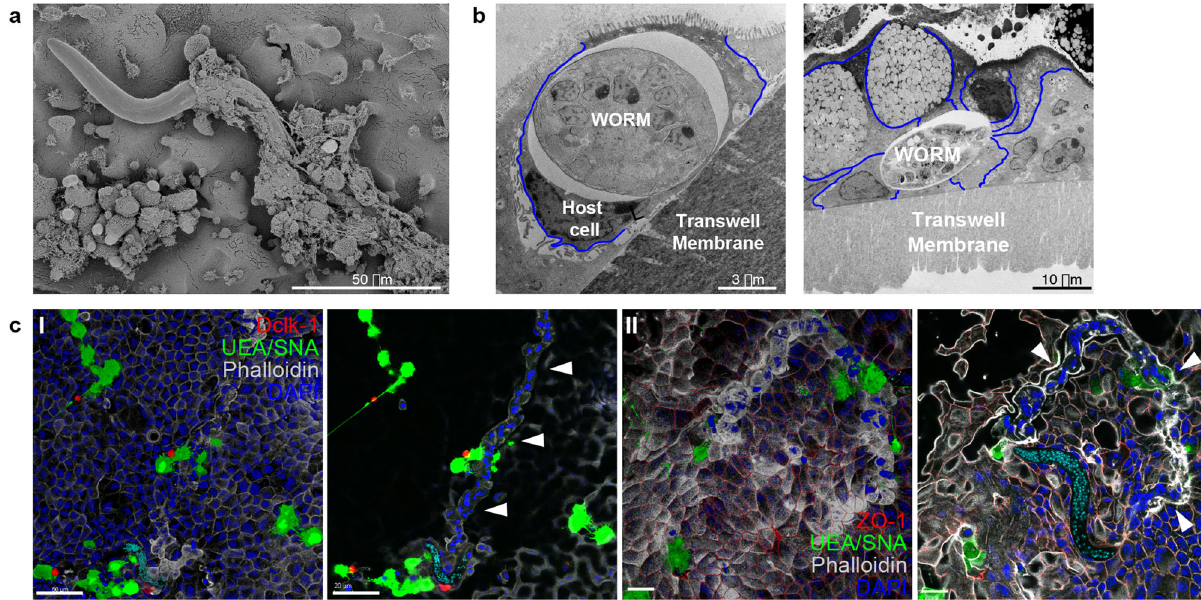
Fig. 4 Caecaloid — T. muris in vitro model reveals intricate path of multi-intracellular tunnels burrowed by whipworm L1 larvae. Scanning and transmission EM images from caecaloids infected with T. muris for 24 h, showing whipworm L1 larvae a invading mucus layers and b within the cytoplasm of host cells. Blue lines show the cellular membranes of the host cells. c Complete z-stack projection and selected and cropped volume of confocal IF images of syncytial tunnels (white arrowheads) in caecaloids infected with L1 whipworm larvae for 24 h. In red, (I) Dclk-1, marker of tuft cells; (II) ZO-1 protein, binding tight junctions; in green, the lectins UEA and SNA bind mucins in goblet cells; in blue and aqua, DAPI stains nuclei of IECs and larvae, respectively; and in white, phalloidin binds to F-actin. Scale bars for (I) 50 μ m, and (II) 20 μ m. Imaging experiments on T. muris- infected caecaloids were performed in triplicate across more than ten independent replicates using three caecaloid lines derived from three C57BL/6